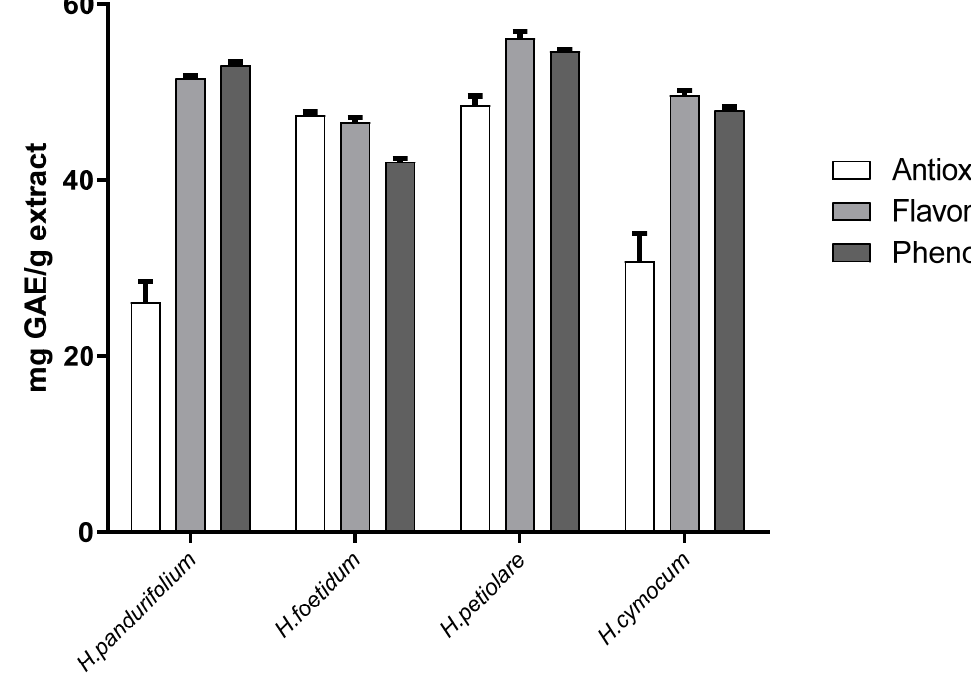
Figure 4. Antioxidant profiles of the aqueous acetone extracts of H. pandurfolium, H. foetidum, H. petiolare , and H. cymocum. Data is illustrated as mean ± SD ( n = 3).